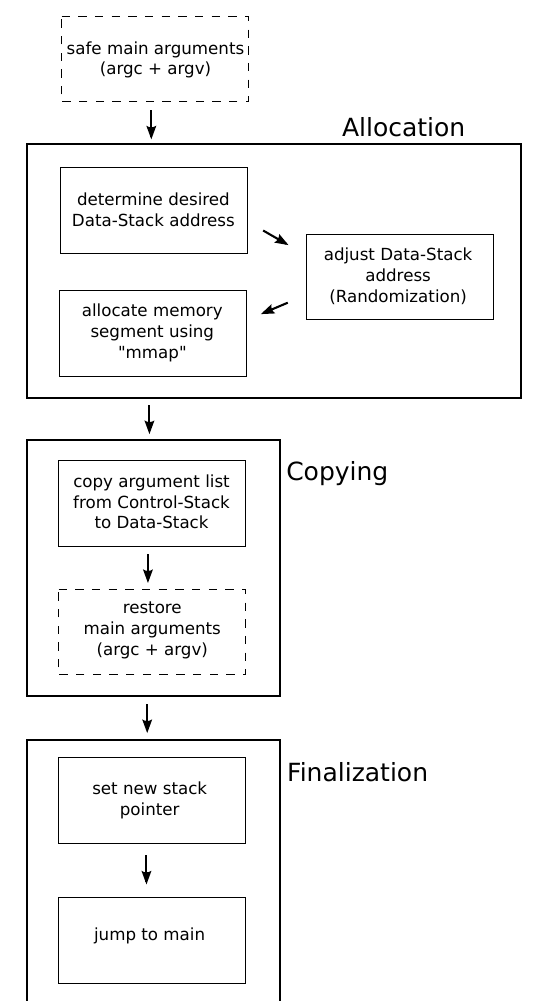
Figure 2. Control-Flow diagram of the initialization phase